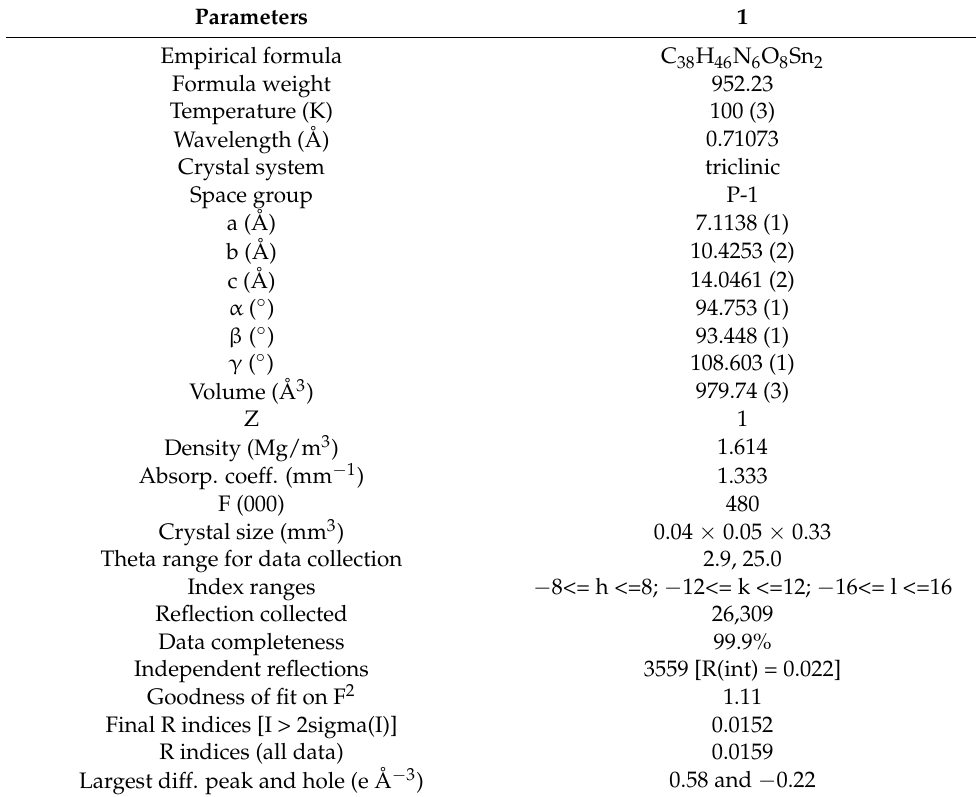
Table 1. Crystal data and structure refinement parameters for complex 1